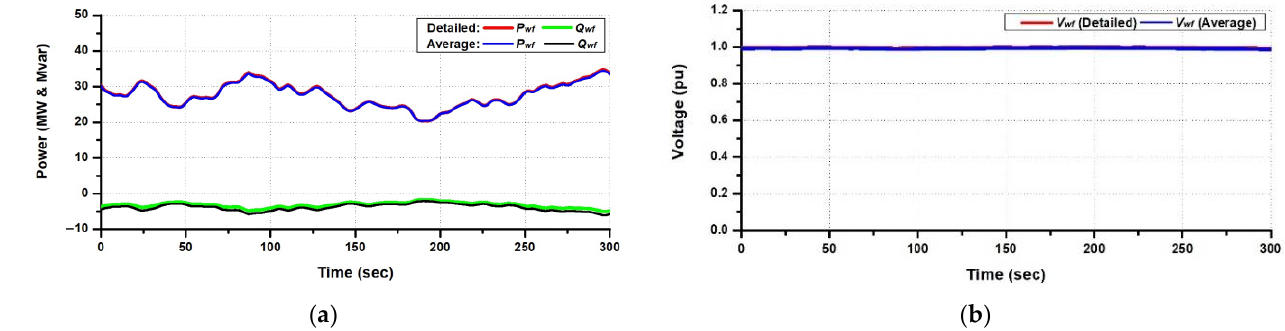
Figure 20. Power output and voltage performances of the wind farm under steady-state condition: ( a ) Total active power and reactive power outputs of the wind farm; ( b ) Voltage profile at Bus B33. Table 4. Computation time of each model for 300 sec steady-state analysis. Computation Time Simulation Detailed Model Average Model Time step